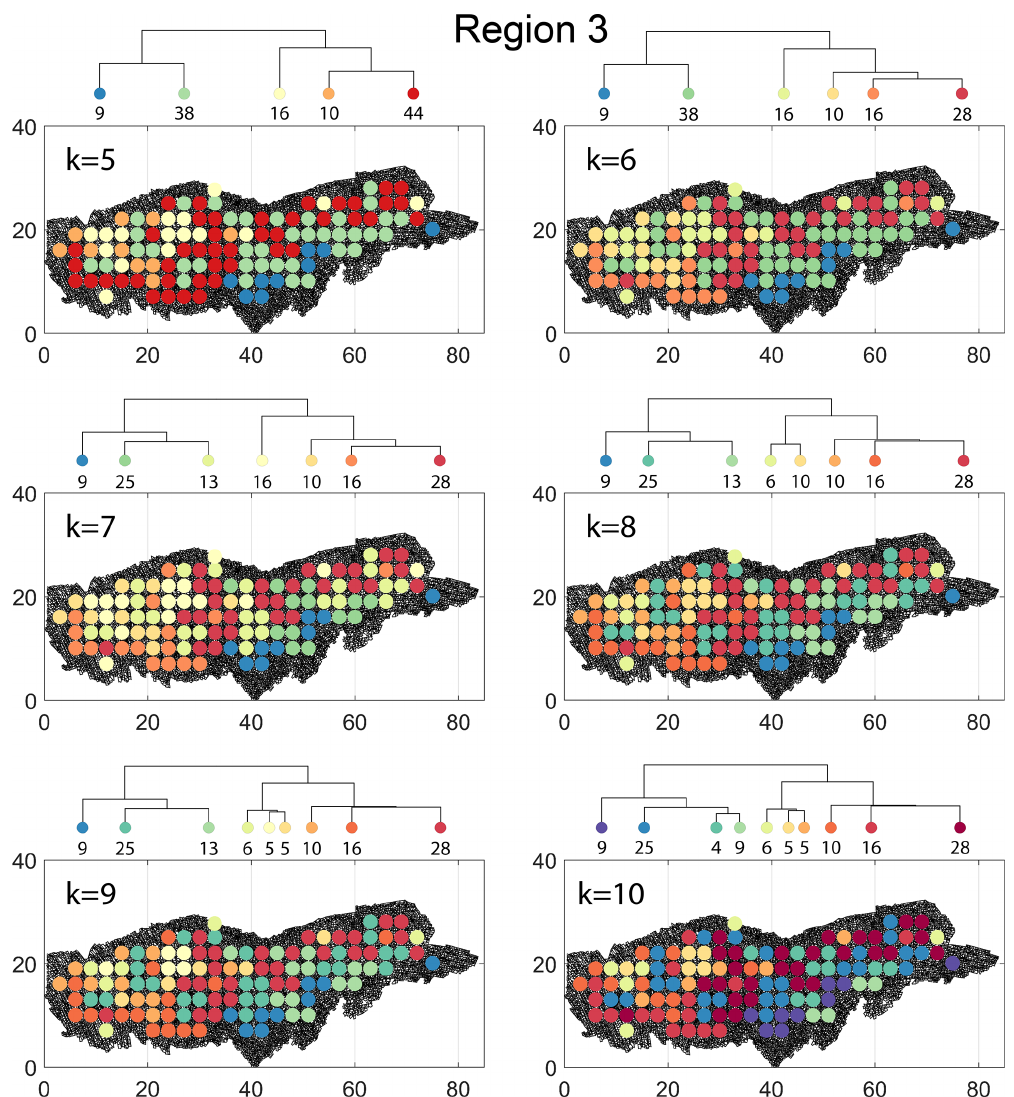
Figure B11. Variation in cluster boundaries for “ k ” clusters in Region 3 using NetLSD.